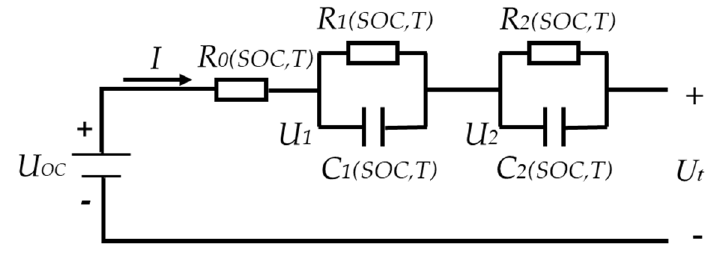
Figure 2. Second-order RC model considering temperature.